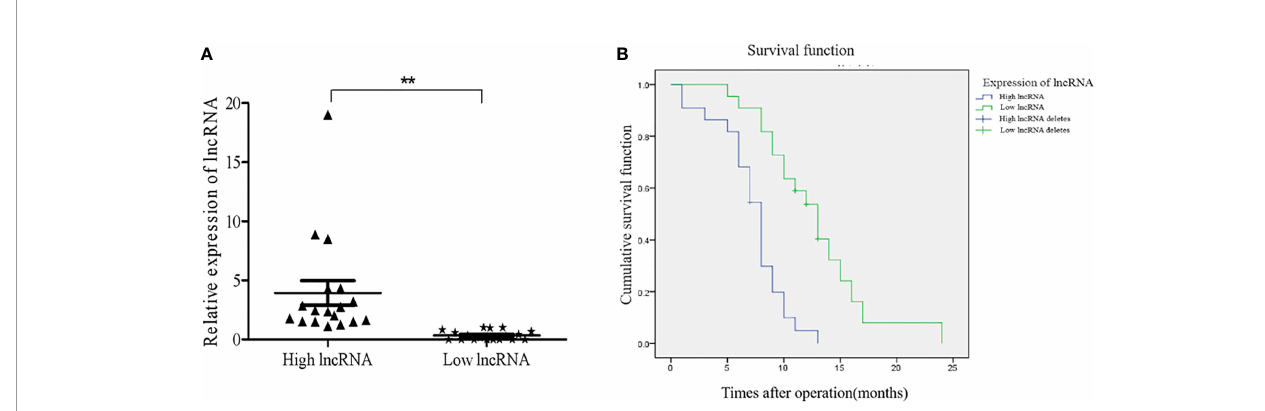
FIGURE 7 | The expression levels of lncRNAs NONHSAT079852.2 in GBM patients and its relationship with the prognosis of patients. (A) qRT-PCR analysis of lncRNA MSTRG224498.5 of GBM tissues. (B) High expression of lncRNA NONHSAT079852.2 correlates with poor prognosis in GBM patients. Results are presented as mean ± SD. ** p